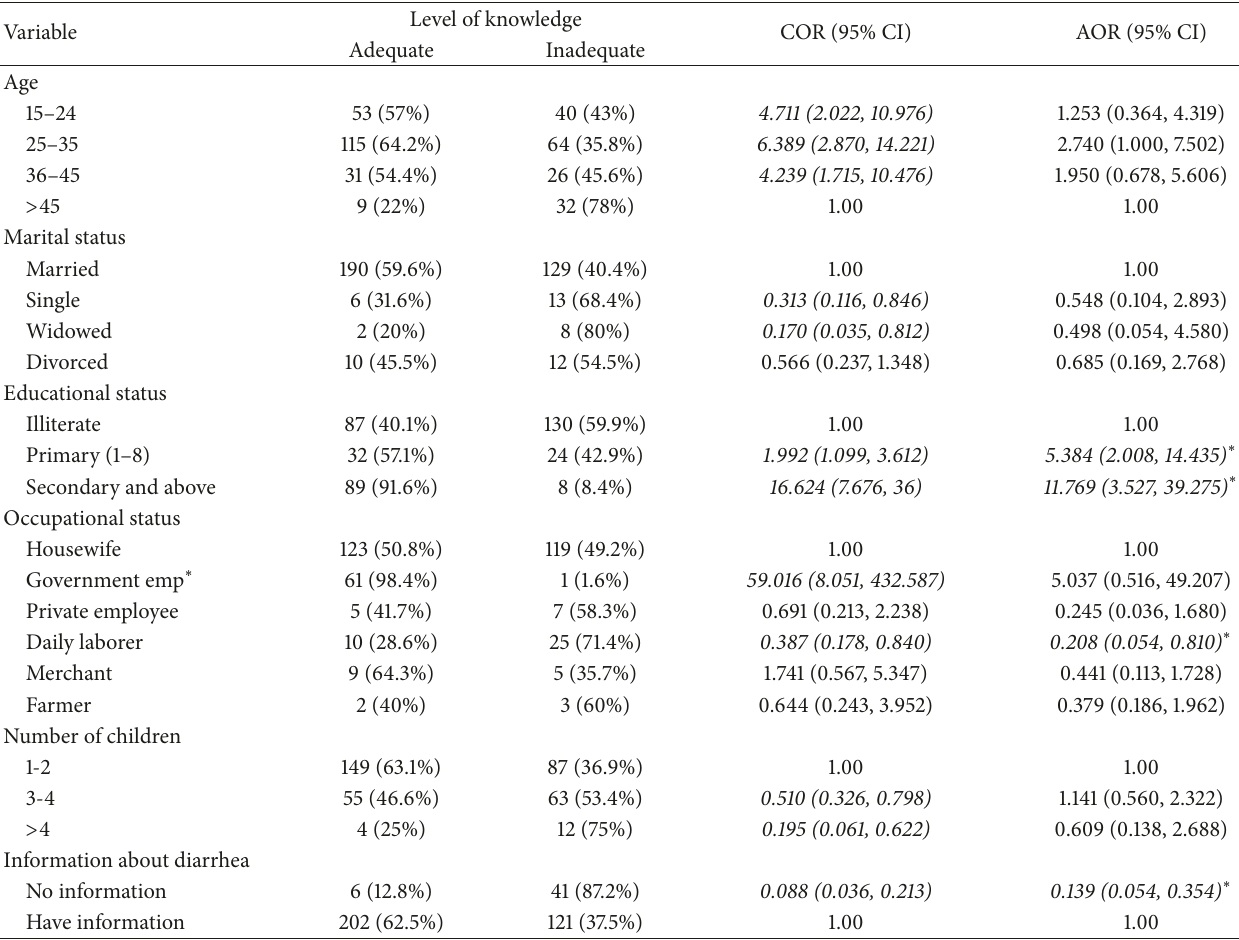
Table 2: Factors associated with knowledge in home management of diarrhea among caregivers attending under-five clinic in Fagita Lekoma district, Northwest Ethiopia,